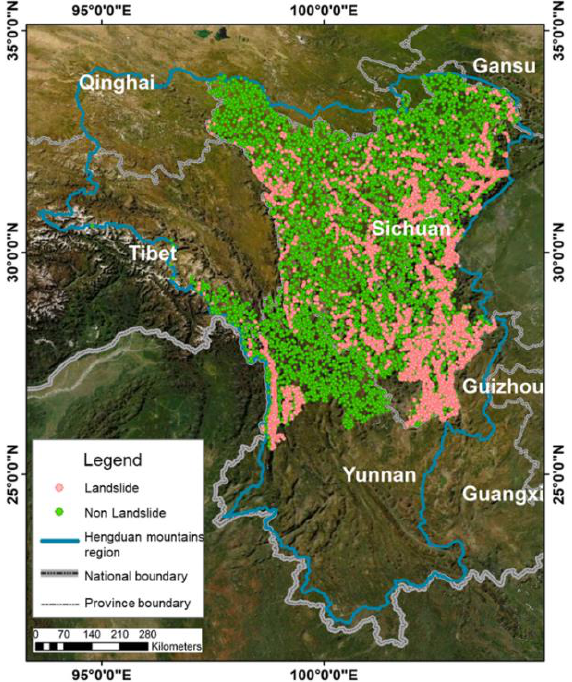
Figure 2. Landslide points obtained from Natural Resources Bureaus of eight administrative divisions after data cleaning. Non-landslide points used the Create Random Point module in ArcGIS.